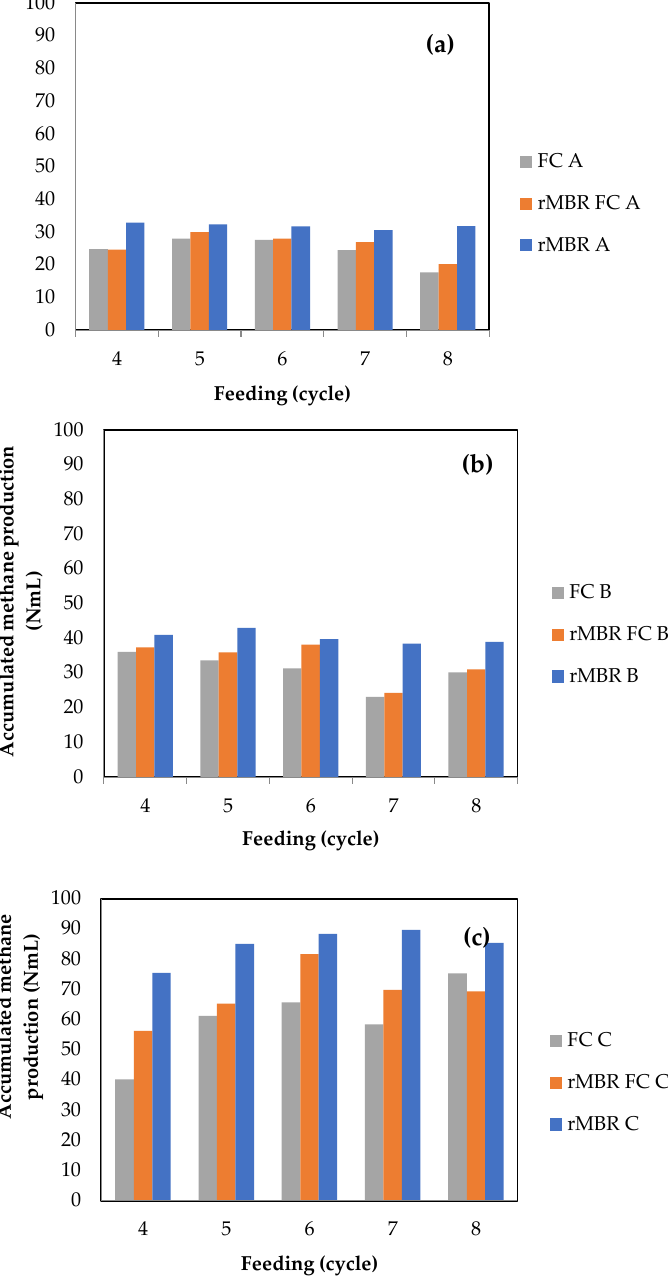
Figure 2. Accumulated methane production after a start-up period for OLRs: ( a ) 0.6; ( b ) 1.2; ( c ) 3.6 g VS/ (L cycle)